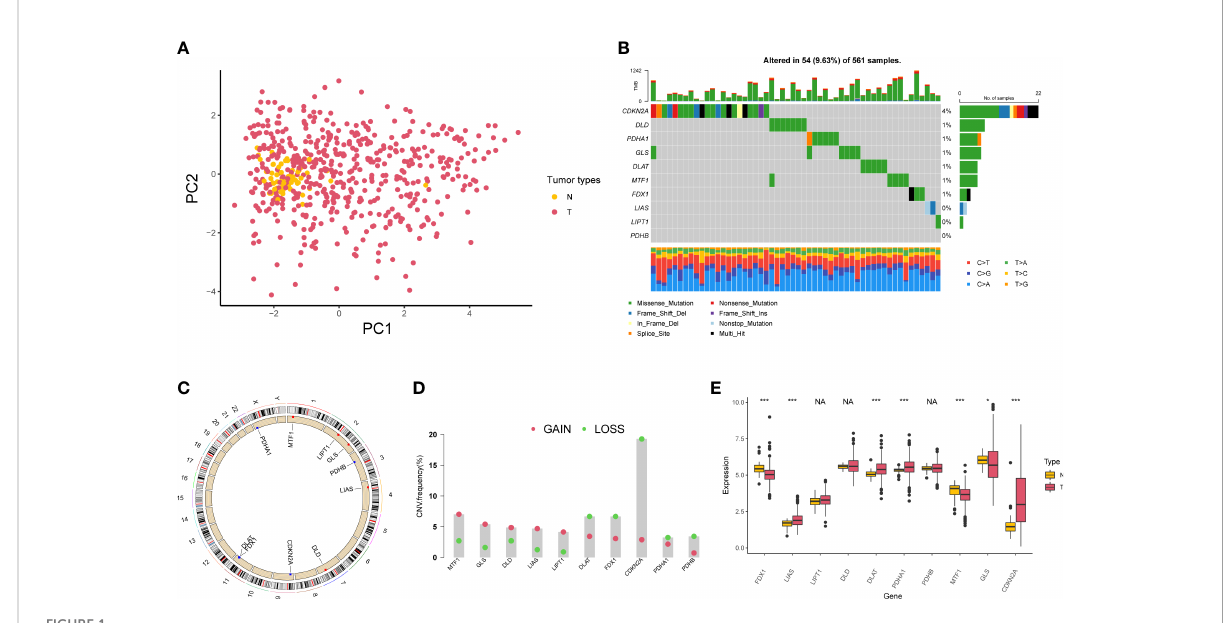
FIGURE 1 Genetic variation of cuproptosis-associated genes in lung adenocarcinoma. (A) Principal component analysis of normal and tumor samples. (B) Mutation of 10 cuproptosis-associated genes in lung adenocarcinoma. (C) Locations of copy number variation alterations in 10 cuproptosis- associated genes on 23 chromosomes. (D) Copy number variation frequency of 10 cuproptosis-associated genes in TCGA-LUAD samples. (E) The boxplot shows the expression of 10 cuproptosis-associated genes between normal and tumor tissues. *P < 0.05; ***P < 0.001; NA, no difference in